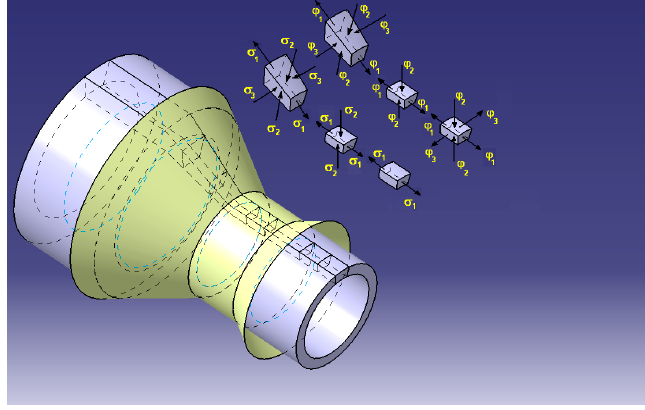
Figure 3. The stresses and strains during drawing over a floating mandrel.